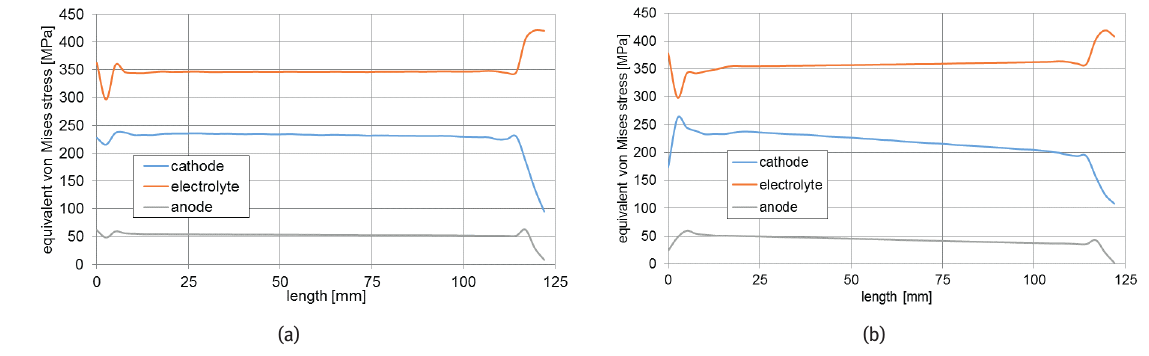
Figure 13: Distribution of operating von Mises stress of the mSOFC stack with supporting structure along the horizontal centerlines of each layer: (a) cross-section I, (b) cross-section II.